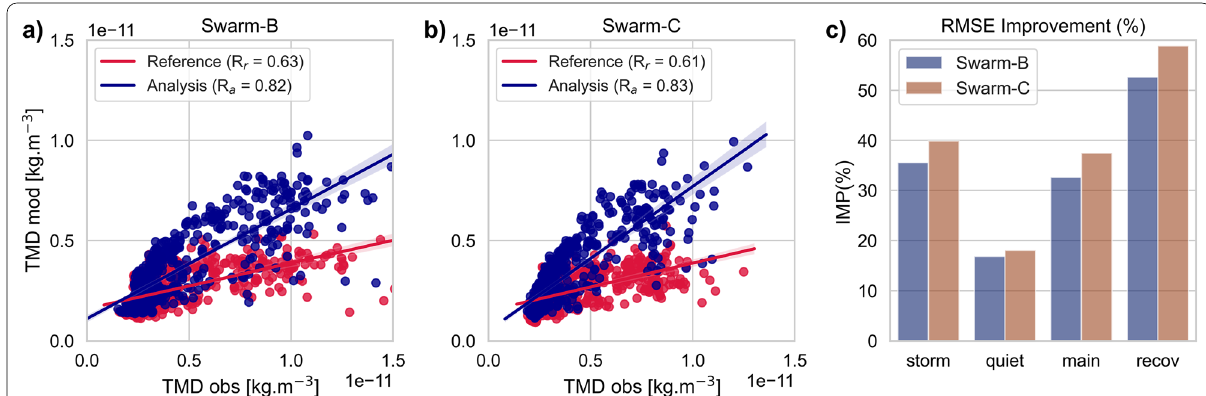
Fig. 3 Reference (red) and analysis (blue) regression against observations for normalized to 400 km thermospheric mass density results of a Swarm‑B and b Swarm‑C. The regression fit (straight line) is represented with its confidence interval (shadowed area). The correlation coefficient (R r , R a ) improves from 0.6 to 0.8 in both satellites. The RMSE improvement ( c ) separated by storm phase and satellite (Swarm‑B in blue and Swarm‑C in red) exhibit an increase with the storm phases from 18% during the quiet day to 55% for the recovery